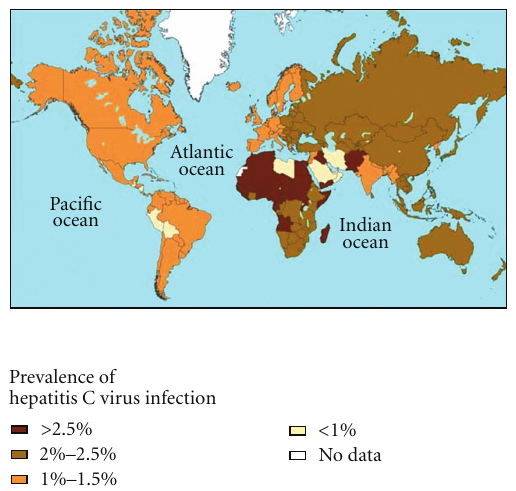
Figure 1: Prevalence of Hepatitis C Infection. Data source: World Health Organization. (Modified from